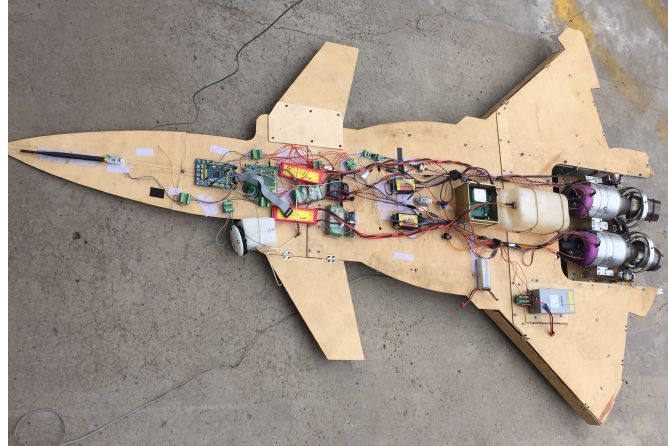
Figure 1. The thrust-vectored tail-sitter unmanned aerial vehicle (UAV).